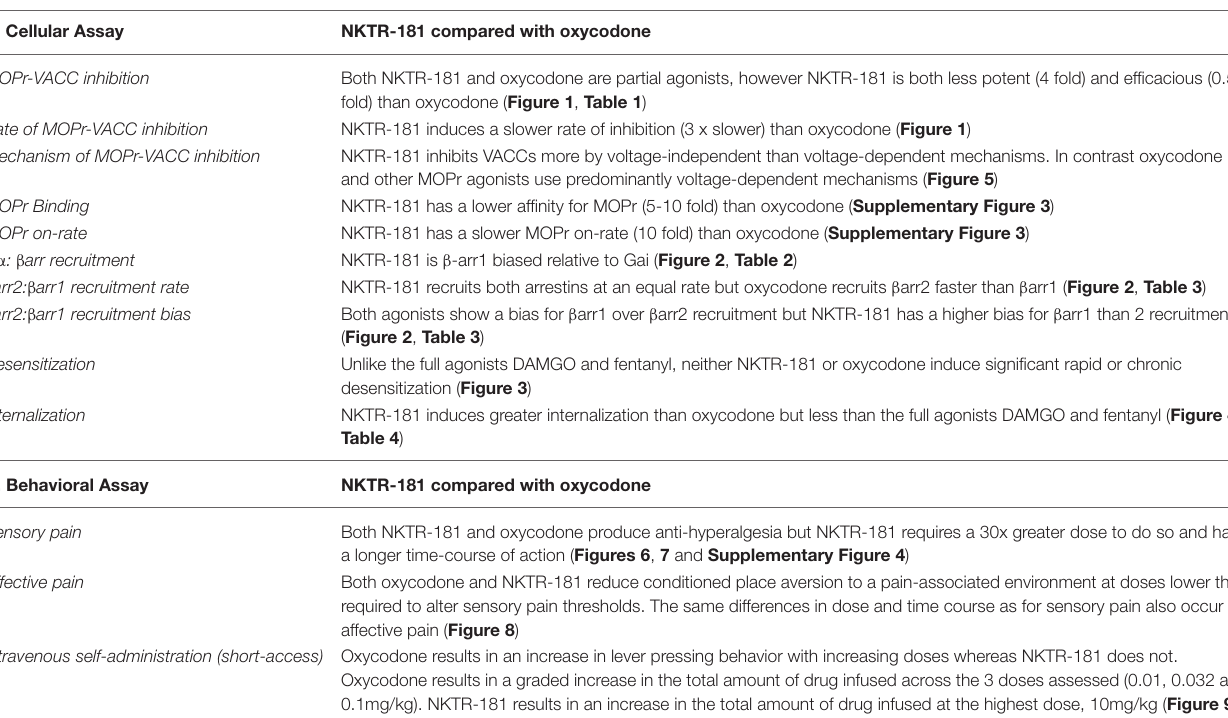
FIGURE 9 | NKTR-181 generates low levels of intravenous self-administration (IVSA). (A) The timetable of this experiment conducted in male and female rats ( n females and 46 males). Once stable responding had been obtained the testing schedule involved an alternating schedule of the test substance, oxocodone, NKTR-181 or saline on 3, 1h sessions on consecutive days, and hydrocodone with each rat randomly receiving 2–3 trials of test substance. (B) The lower doses of NKTR-181 (1 and 3.2 mg/kg/infusion) induced the same number of reinforcers as saline and the highest dose (10 mg/kg/infusion) a lower number of reinforcers than saline. (C) The total amount of drug infused for each session increased by the highest (10 mg/kg) but not lower doses (1 and 3.2 mg/kg). (D) In contrast to NKTR-181, the low (0.01 and 0.032 mg/kg/infusion) but not high (0.1 mg/kg/infusion) dose of oxycodone-induced higher responding than saline. (E) When compared to the total amount of drug infused at the lowest dose, the total amount increased with each of the two higher doses. * p < 0.05, ** p < 0.01, and *** p < 0.001. Data are shown as violin plots. Refer to Supplementary Table 3 for statistics. TABLE 5 | Summary of the differences and similarities between NKTR-181 and oxycodone in cellular and behavioral assays. A. Cellular Assay NKTR-181 compared with oxycodone MOPr-VACC